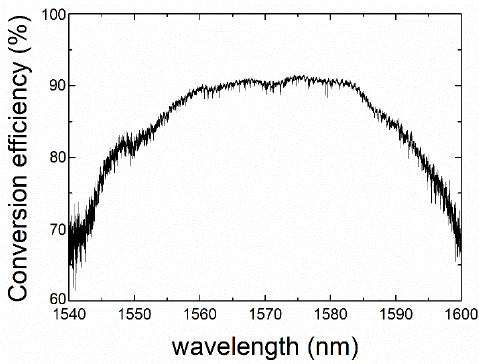
Figure 12. Measured E 00 -E 10 conversion efficiency of fabricated mode converter in 1540 – 1600 nm.